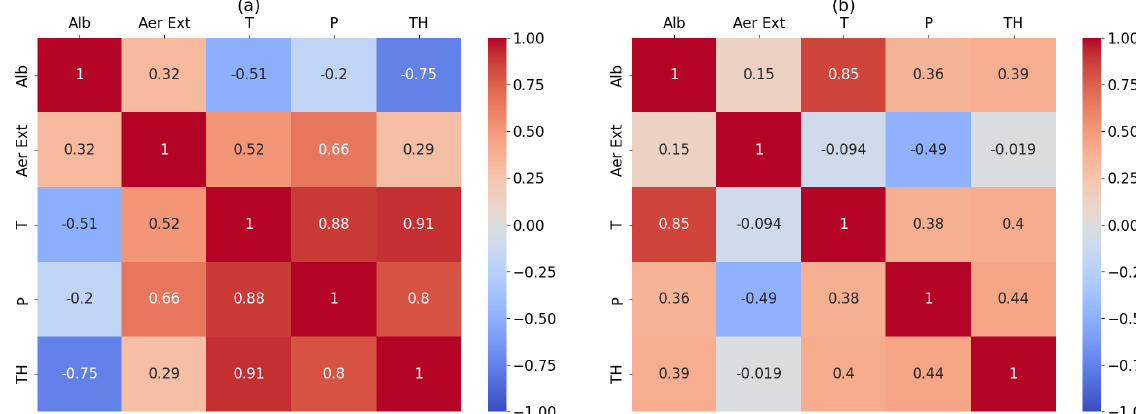
Figure 13. Correlation matrices between several error components for autumn. (a) Pearson correlation coefficient over latitudes at 30km; (b) correlation coefficient for northern mid-latitudes over